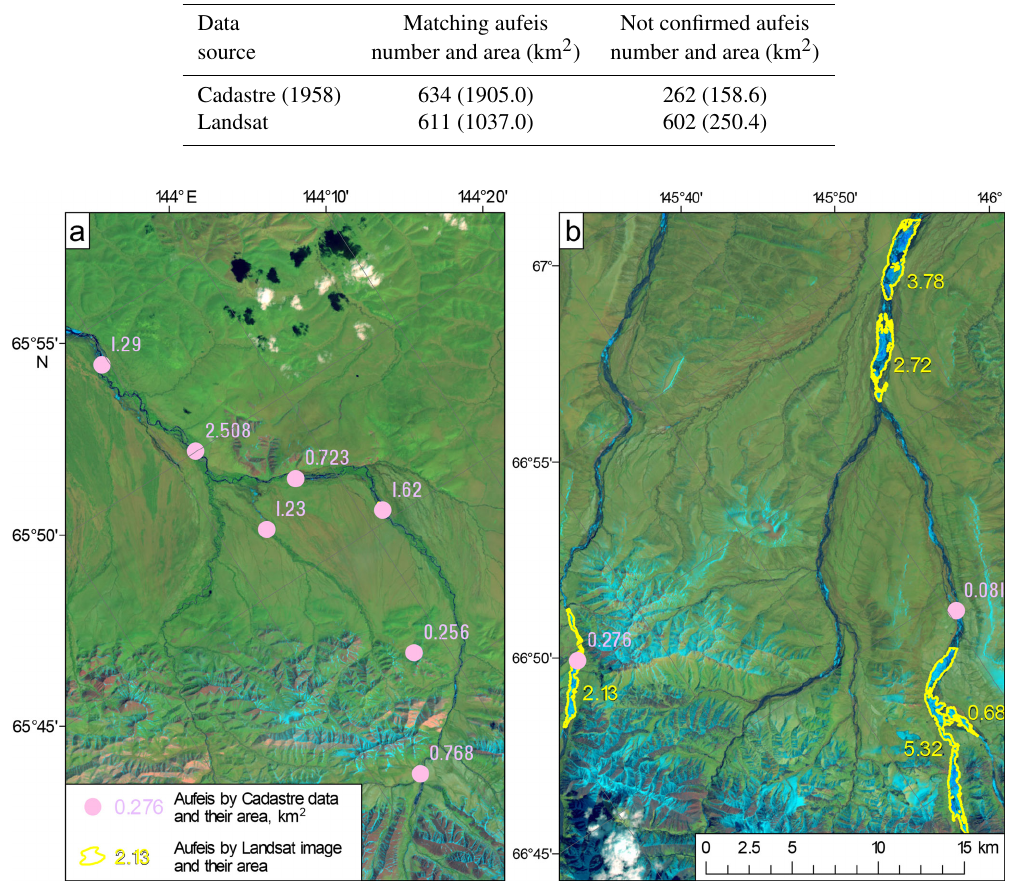
Figure 3. Difference between aufeis location according to the Cadastre and satellite data: (a) aufeis fields are absent in the image but present in the Cadastre (Landsat-8 image of 18 June 2017) and (b) aufeis fields are absent (or their area is understated) in the Cadastre but present in the image (Landsat-8 image of 30 May 2016).